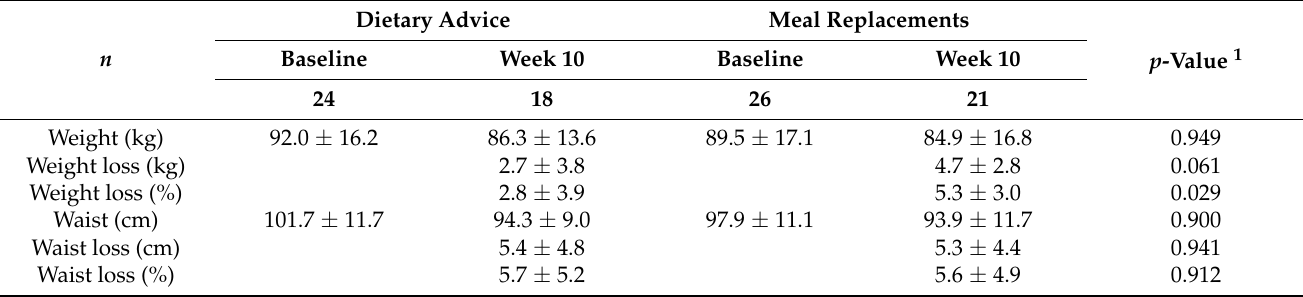
Table 3. Changes in weight and waist